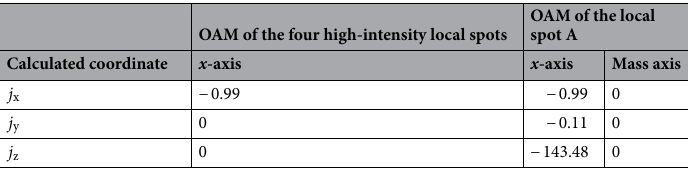
OAM of the local spot A